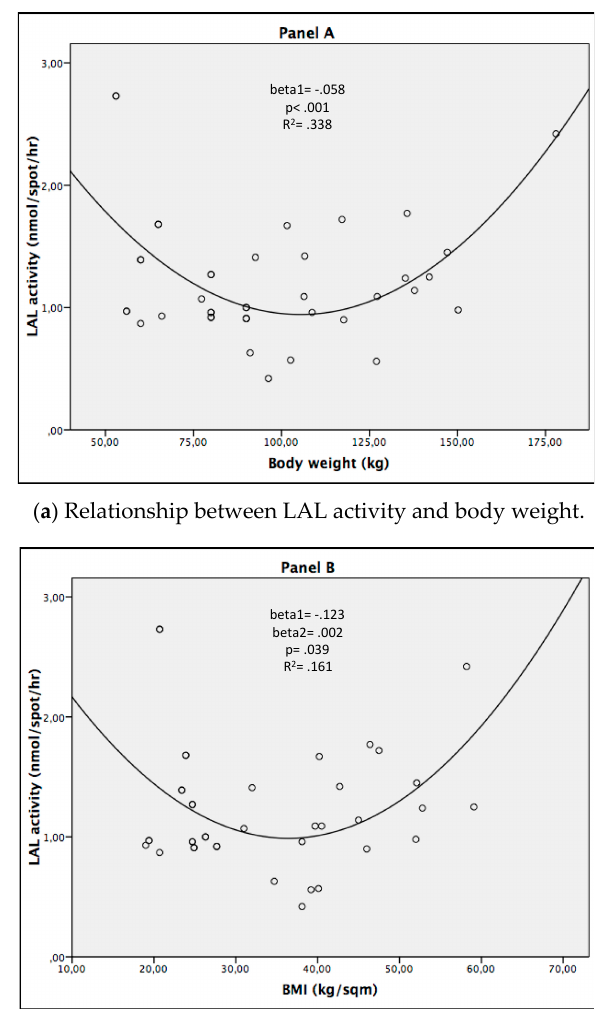
Figure 2. Differences in lysosomal acid lipase (LAL) activity among healthy subjects and obese patients before and after VLCKD.